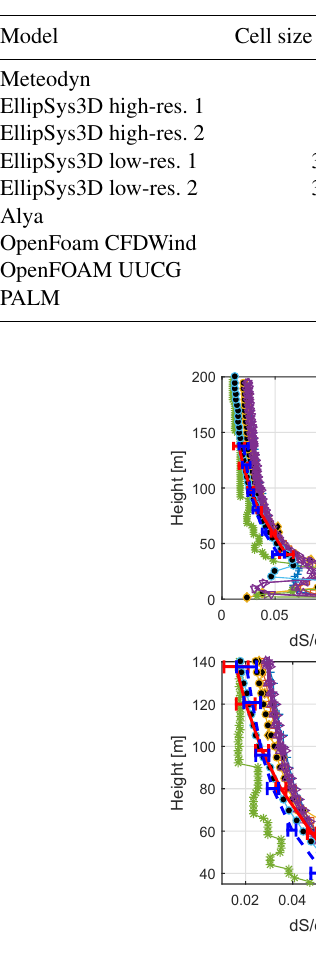
Figure 4. Modelled and observed wind shear. The lower three plots are zoomed in on the instrument heights to increase readability. The blue dashed line shows the average from the cups, and the red full line shows the average from the sonics. Error bars indicate the 95% confidence level for the mean value. The various other markers indicate simulated wind speeds. Please see Table 1 for the marker representations. LES models have been given black filling in order to increase readability. (a, d) Results from 100 ◦ , (b, e) from 240 ◦ , and (c, f) from 290 ◦ .